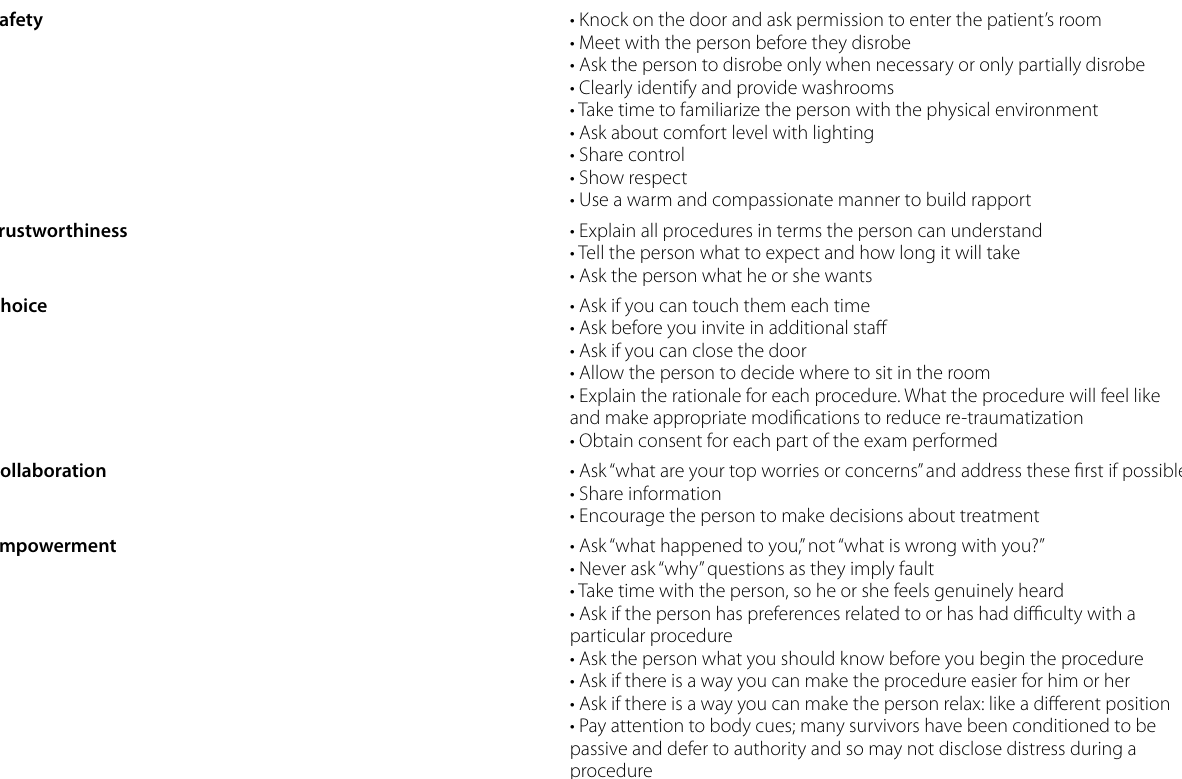
Table 1 Components to consider minimization of re-traumatization (adapted with permission from Subramanian and Green 2015)